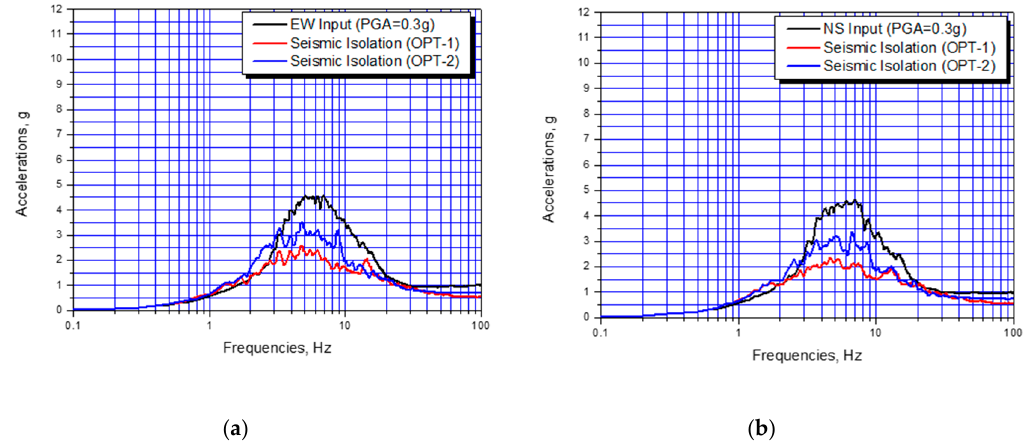
Figure 6. Response spectrum for PGA = 0.3 g: ( a ) EW direction; ( b ) NS direction.